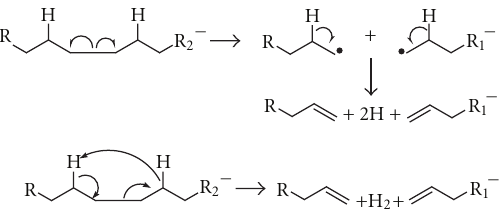
Scheme 6: The charge remote fragmentation (CRF) mechanism for the formation of distonic ions (anions) and terminally unsaturated ions